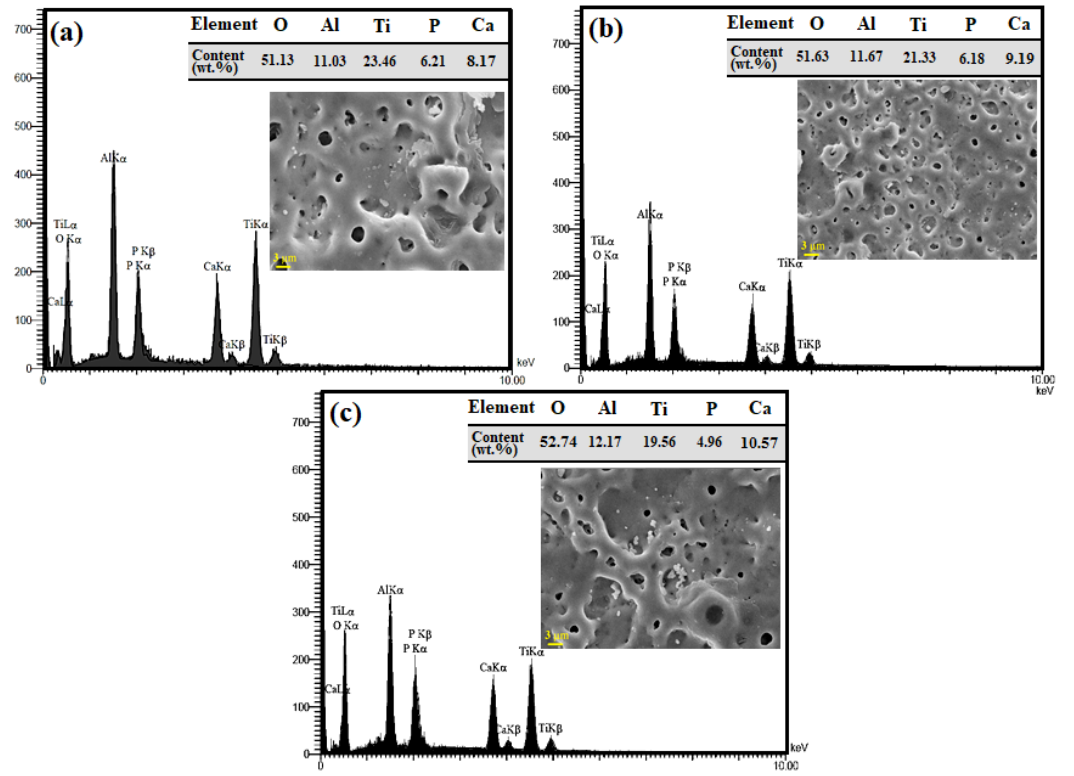
Figure 7. EDS spectra and surface morphology of PEO coatings prepared under applied voltages of ( a ) 400 V, ( b ) 450 V, and ( c ) 500 V after immersion in SBF for 28 days. ( a ) 400 V, ( b ) 450 V, and ( c ) 500 V after immersion in SBF for 28